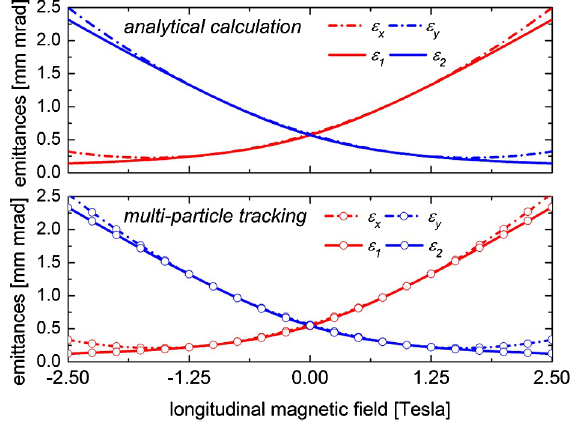
FIG. 4. Eigen-emittances and rms emittances calculated by the analytical method based on the decoupling matrix of Eq. (22) and by multiparticle tracking through the EMTEX beam line. 1.0 T.